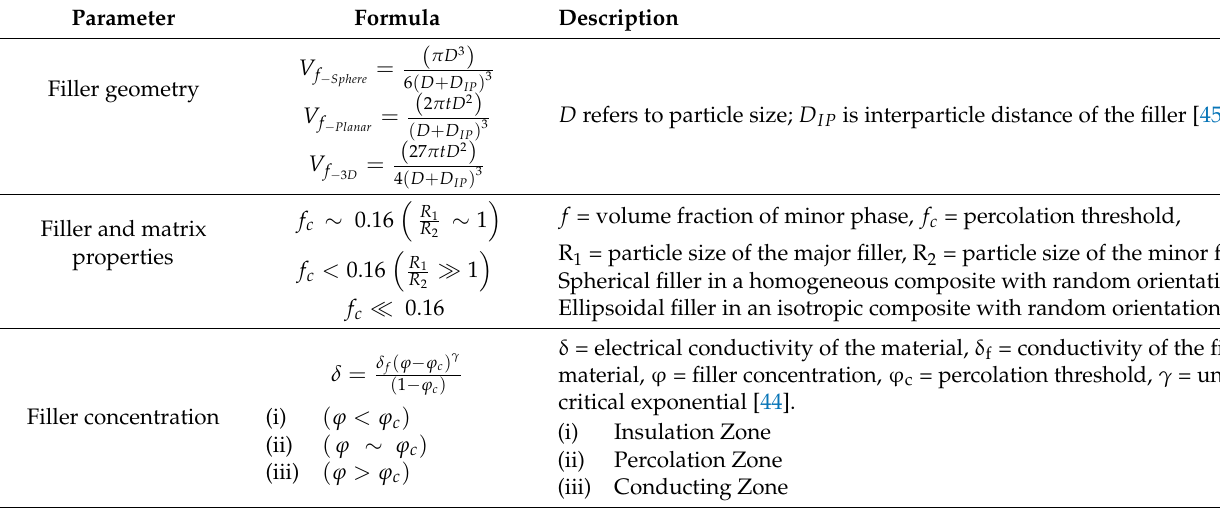
Table 4. Influencing parameters of the percolation